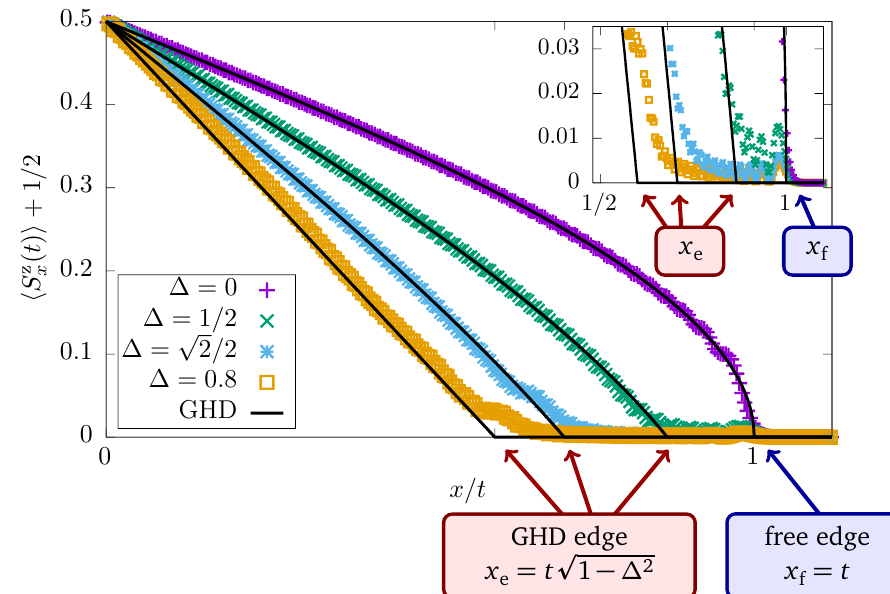
Figure 6: Numerical density profiles for x > 0, shown as a function of x / t at time (cid:16) sin π (cid:17) x ( t ) 〉 = − q q t = 240. The data is compared to the GHD formula 〈 S arcsin x t 2 π sin γ for γ/π = p / q irrational, − x otherwise. Inset: zoom on the region (cid:112) 2 t sin γ [ x ] = [ t 1 − ∆ 2 , t ] between the GHD edge and free edges, where the GHD , x e f prediction vanishes but subleading corrections remain. For x > t , density vanishes super-exponentially fast for all values of ∆